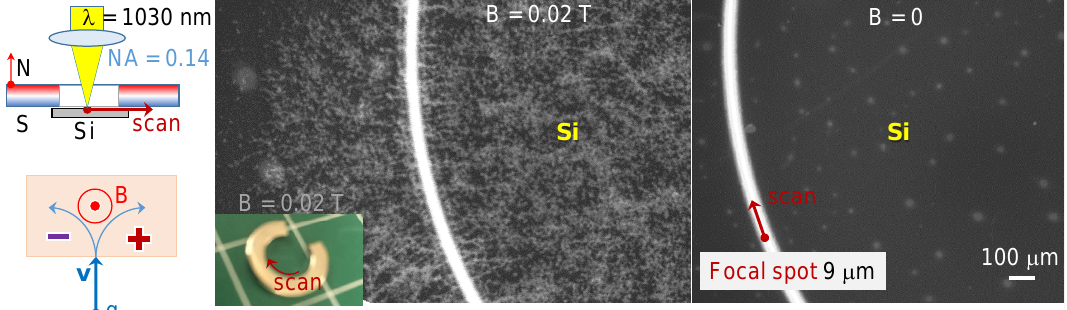
Figure 6. Debris formation for ablation of Si sample with a B = 0.02 T magnet placed on it. Laser was scanned along the internal rim of the magnet at constant distance. For the B = 0 case, the same size and shape non-magnetic material was used. Conditions: scan speed v s = 100 µ m/s, constant density mode with 250 pulses/ µ m, pulse energy E p = 25 nJ ( T = 0.82 transmission of the objective lens; NA = 0.14), and a laser repetition rate f = 200 kHz. Experimental geometry and charge separation due to Lorentz force are schematically